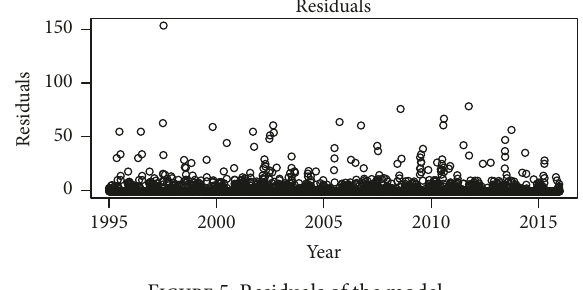
Figure 5: Residuals of the model.